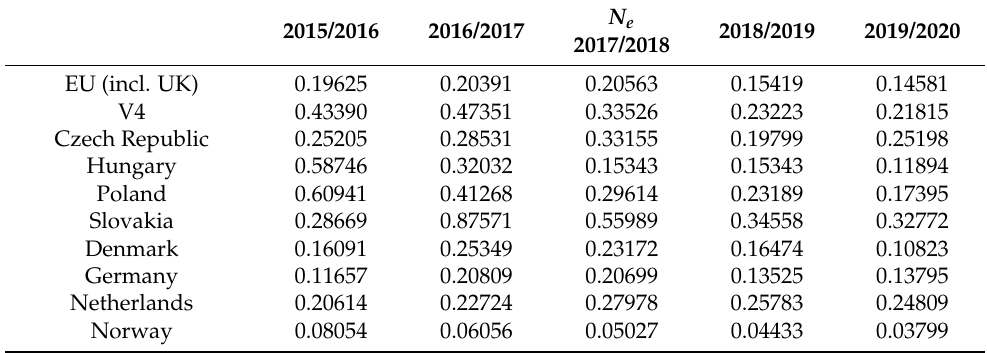
Table 10. Number of public charging stations per plug-in electromobile ( N e ) at the turn of the